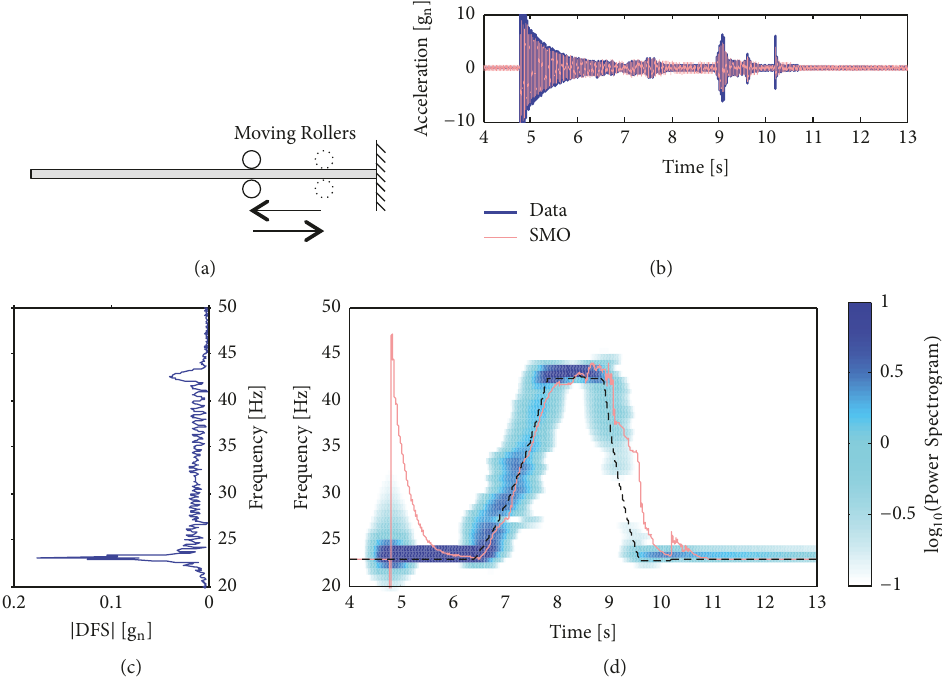
Figure 6: Results from the moving roller experiment. (a) Diagram of the beam with moving rollers. (b) Amplitude of the discrete Fourier series (DFS) of the tip acceleration. (c) Time history of the tip acceleration. (d) Spectrogram of the tip acceleration while the rollers move. The dashed line shows the natural frequency estimated from the cart position obtained from the encoder on the linear